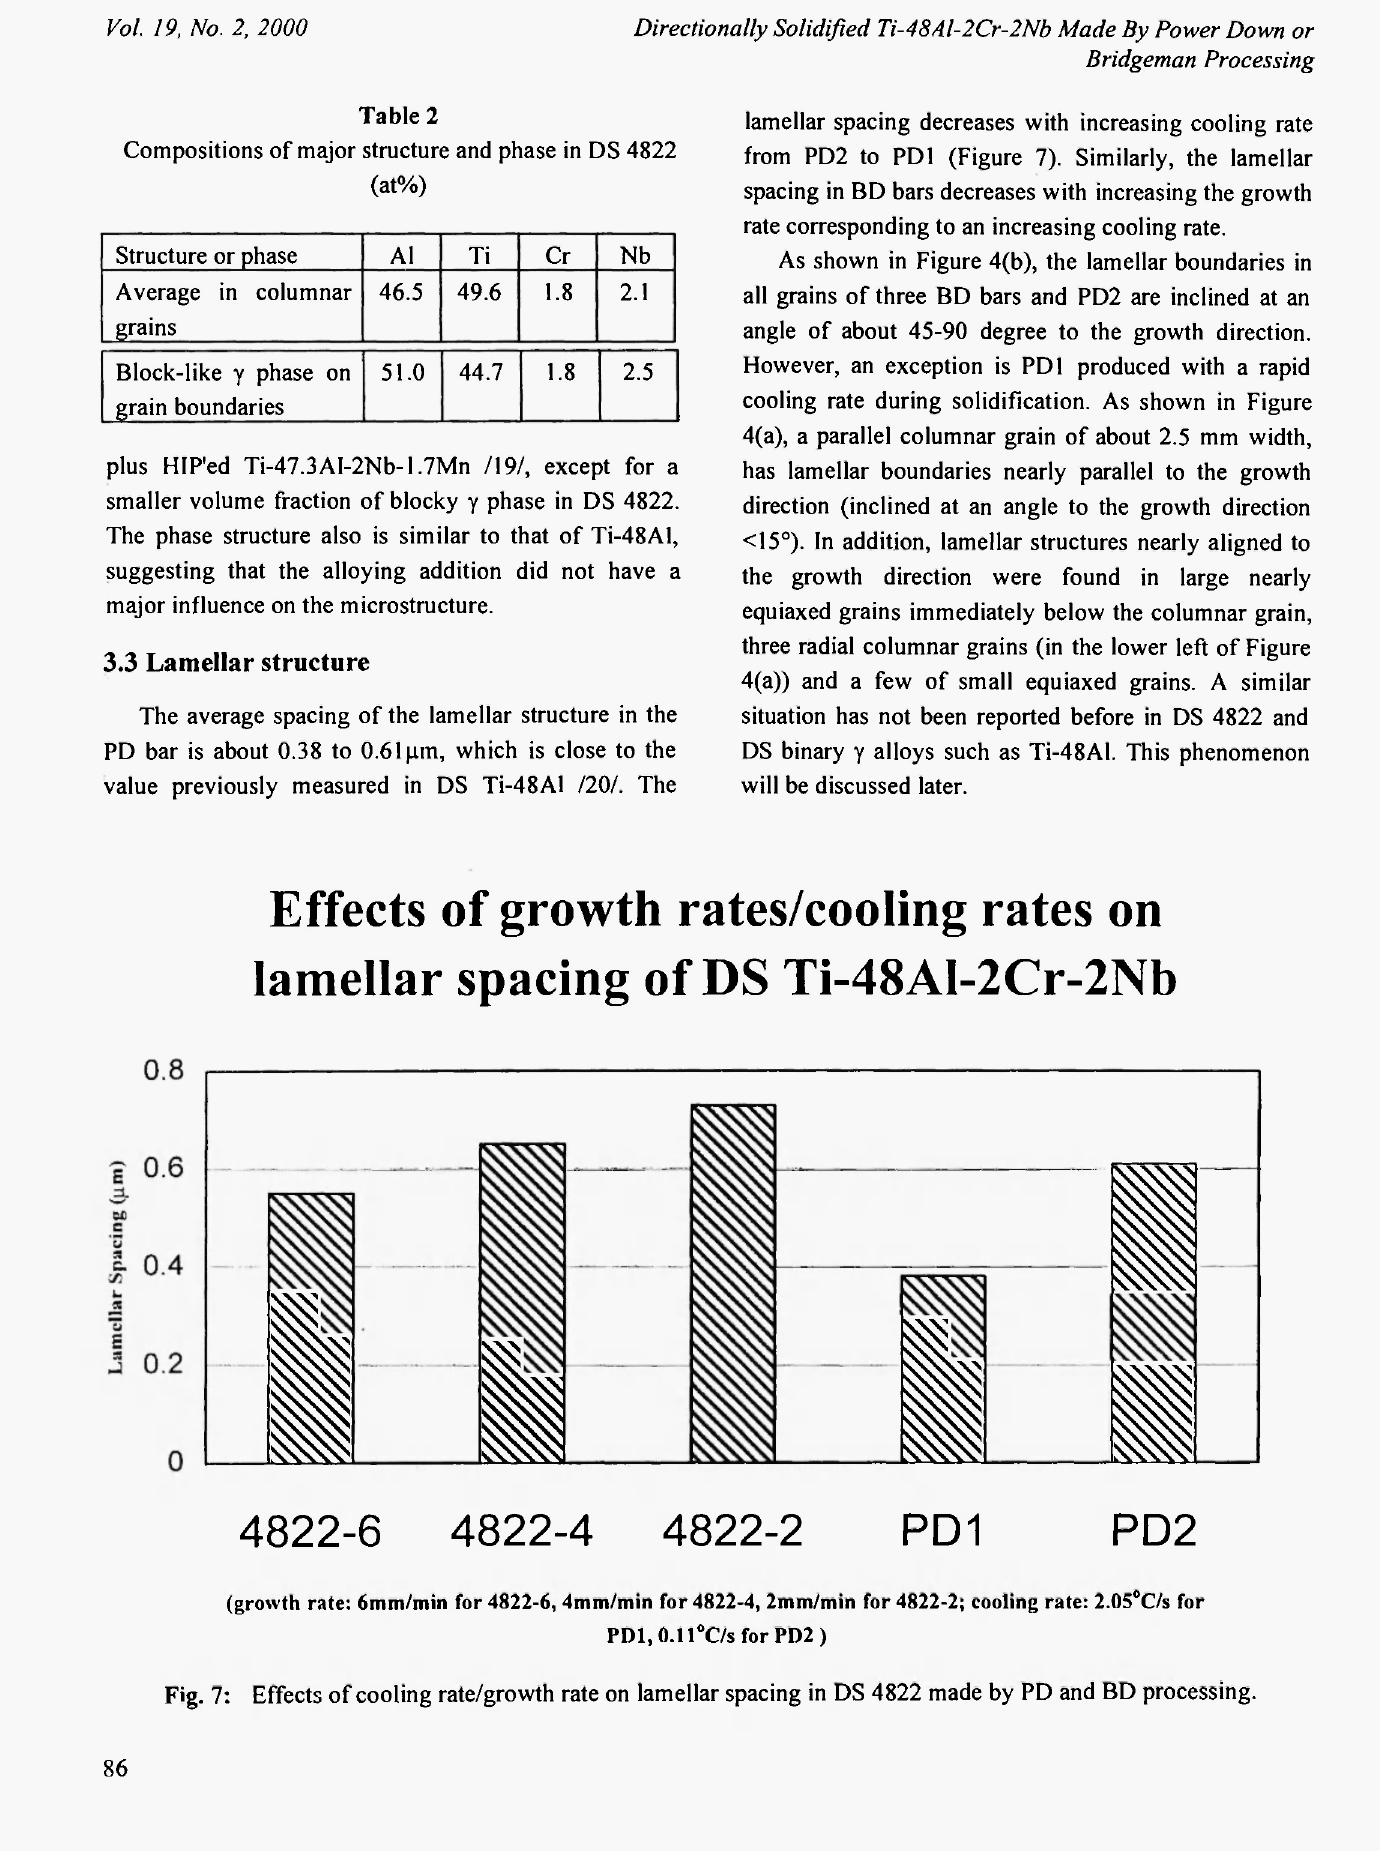
Fig. 7: Effects of cooling rate/growth rate on lamellar spacing in DS 4822 made by PD and BD processing.